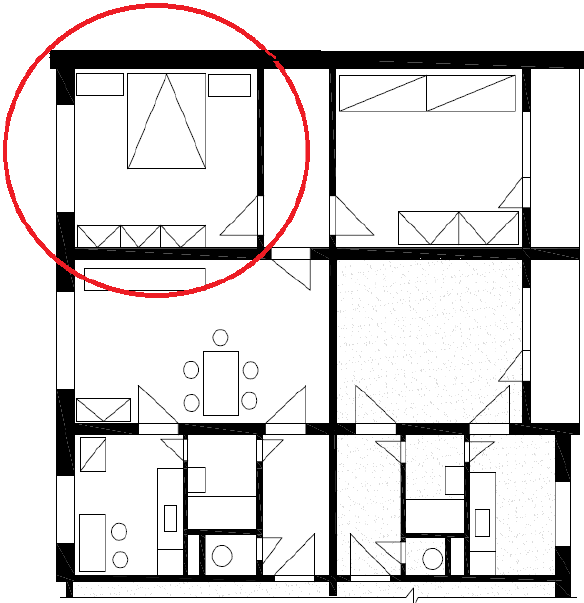
Figure 4. Ground plan: floorplan of the reference apartment.